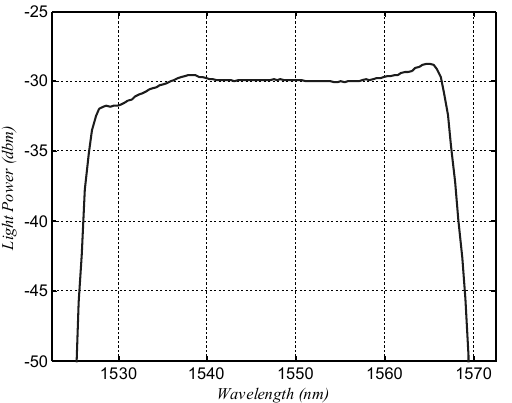
Figure 5. The spectrum of a broadband-amplified spontaneous-emission (ASE) light source.